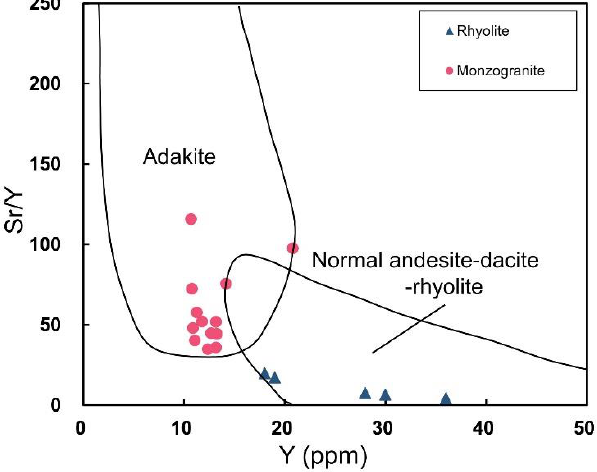
Figure 7. Sr/Y classification diagram for the Demingding monzogranite and rhyolite, after [45].